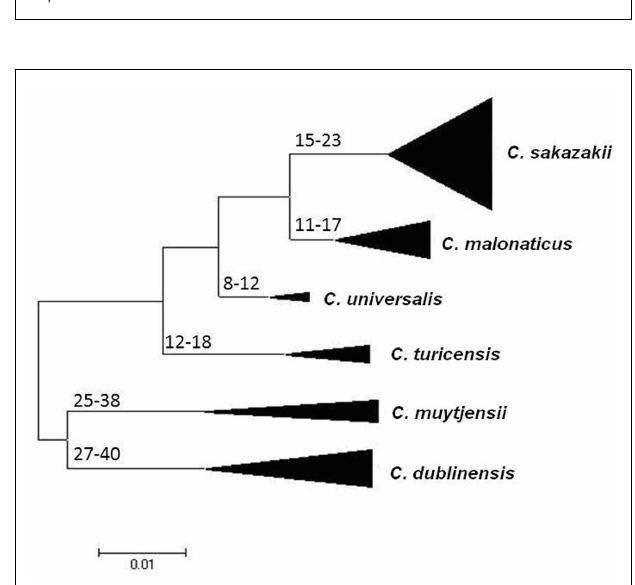
FIGURE 2 | Maximum Likelihood tree of the Cronobacter MLST dataset indicating ranges of the hypothetical divergence dates of each species node measured in millions of years before the present. The tree has been drawn to scale using MEGA5.The bases of the triangles indicate the number of isolates used for the analysis, while the heights indicate the diversity of each branch. C. condimenti with the single isolate has been excluded from this analysis. Reproduced from Joseph et al.